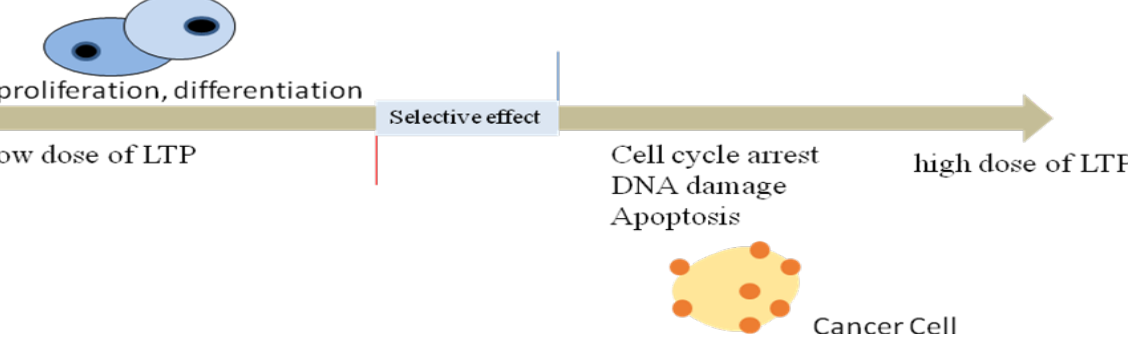
Figure 1. Selective effects of the optimal dose of LTP. Low doses of LTP can increase the proliferation and differentiation of normal cells, while high doses can cause cell cycle arrest, DNA damage, apoptosis to kill cancer cells.